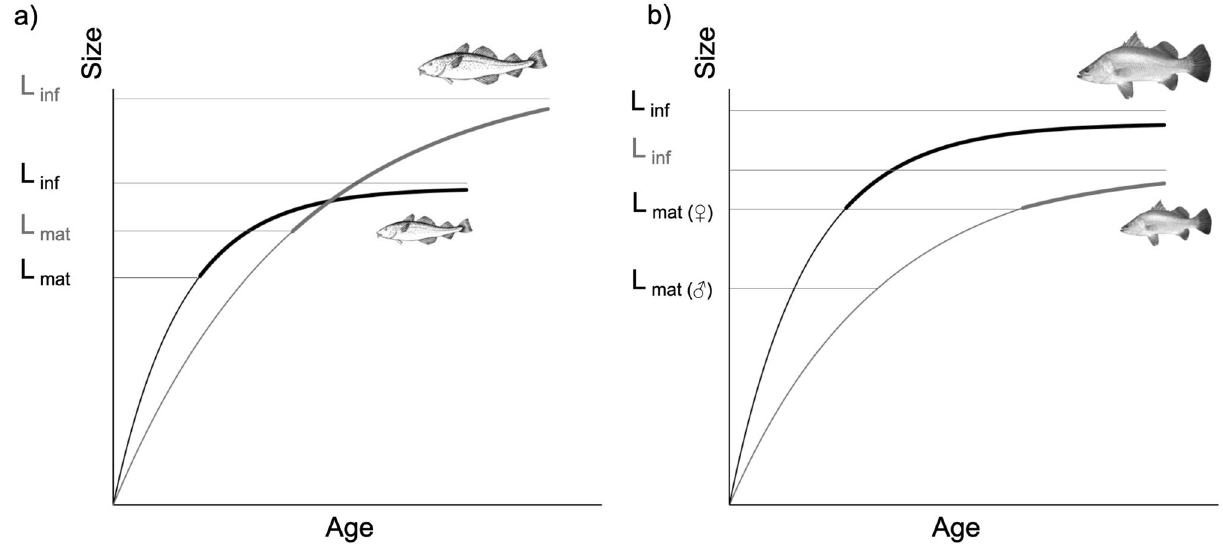
Figure 3. ( a ) Von Bertalanffy growth curves representing slow (grey line) and fast (black line) life histories in Atlantic cod. Thickened lines indicate length of maturity for the different life histories (modified from Audzijonyte et al. 66 ). Trade-offs between growth and reproduction drive a continuum between slow (late maturation; high L-infinity) and fast (early maturation; low L-infinity) life histories, which are stable in an evolutionary sense in the absence of size-specific mortality. ( b ) In contrast, fast barramundi growth rates (black line) are linked to younger female maturation and larger size-at-age throughout the life history relative to slow growth rates (grey individual variation in maturation schedules of barramundi (sensu 51 ; Fig. 3). If such trade-offs were strongly influencing individual variation in sex change schedules, slow-growing individuals would be expected to ulti- mately attain larger sizes than those that initially grew fast and matured as females at young ages, as is the case for Atlantic cod ( Gadus morhua ; Fig. 3a). Fishing practices targeting large, fast-growing Atlantic cod have reportedly driven a rapid evolutionary shift towards fast life-histories 52 . Our results suggest that similar fishing effects would be unlikely to influence barramundi life-histories in the same way, but may nonetheless potentially have deleterious effects on recruitment. Coinciding with a period of increased fishing pressure, the proportion of female barramundi in the Fly river in Papua New Guinea reportedly declined from 27% in 1973 to 13% in 1978, which was not accompanied by a compensatory decline in the size at which males changed sex (Anon, cited in 31 ). If large, fast-growing barramundi are disproportionally targeted by fisheries, it is likely that declines in female biomass may reduce population fecundity. The largest barramundi in our samples were characterised by rapid growth throughout ontogeny. The apparent primacy of rapid growth with respect to fitness suggests that extrinsic factors may be a key driver of individual variation in sex change schedules (see 53 ). For example, individuals with the highest fitness may simply be those that encountered favourable environmental conditions or lower rates of competition within local habitats during the early life history. It is also plausible that maturation schedules are influenced by phenotypic variation. For example, Luiz, et al. 54 reported that individual variability in barramundi mouth gape was linked to body condi- tion, where individuals with larger mouths tended to be in better condition. Presumably, these large-mouthed individuals would also have faster growth rates, suggesting that morphological characteristics may influence the timing of sex change. Our results could also be influenced by non-linear relationships between growth and maturation. For example, Alm 55 suggested that Eurasian perch Perca fluviatilis with intermediate growth rates mature at large size, whereas fast- and slow-growing individuals mature at intermediate and small sizes respec- tively. Since our analyses did not include ‘intermediate’ sex-change schedules, such non-linear effects may not have been captured if they occur in barramundi. Given the degree to which juvenile growth shapes size-at-age for subsequent life-history stages, these results suggest that conditions experienced during the early life history may strongly influence the timing of sex change (see 56 ). Variation in maturity schedules may partially be shaped by the protracted spawning of barramundi, as individuals spawned at the beginning of the breeding season may get a ‘head start’ of several months on conspe- cifics spawned later 32,34 . During this period, young-of-year barramundi become increasingly piscivorous with increasing size (including cannabalism 57 ), which may facilitate rapid increases in growth rate (see 58 ) and drive extreme size heterogeneity within cohorts 59 . Thus, recruits that are spawned earlier in the breeding season, or encounter high quality habitats during the early life-history, may potentially obtain a substantial size advantage over those that are spawned later, and in turn might attain female status at a younger age. Variation in sex change schedules may also be partially shaped by environmental heterogeneity. As is typical of riverine environments in the wet/dry tropics of northern Australia, flows in the Fitzroy system are highly seasonal, peaking during the monsoon season and progressively decreasing throughout the dry season. The dura- tion and magnitude of wet season flows also varies considerably between years 38,60 , and years of high discharge